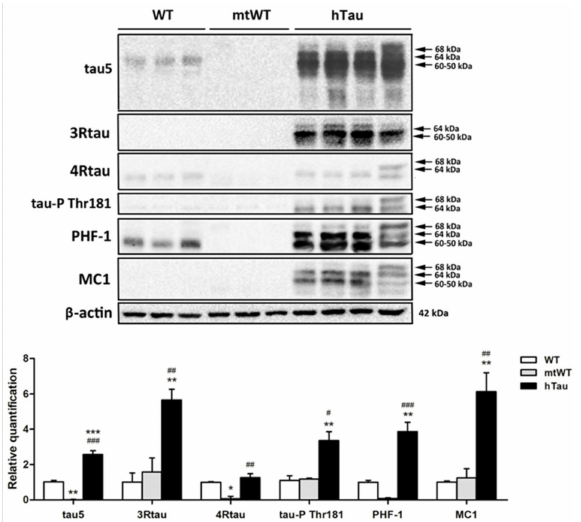
Figure 2. Gel electrophoresis and Western blotting of total brain homogenates from WT, mtWT, and hTau transgenic mice at the age of 9 months processed with Tau 5, 4Rtau, 3Rtau, phosphorylated tau at Thr181 (tau-Pthr181), PHF1, and MC1 antibodies, and processed in parallel. β -actin was used as a control of protein loading. Since the profile of β -actin was similar in the different Western blots, only one representative example is included in the figure. WT mice show the presence of total tau (tau 5), mainly composed of 4Rtau. A PHF1-immunoreactive band is also observed in WT mice; the presence of this band correlates with PHF1 immunoreactivity in the neuropil in these mice. Western blots using tau-P, Thr181, and MC1 antibodies are negative. hTau transgenic mice express a large amount total tau manifested in sbands of 68 kDa, 64 kDa, and 60–50 kDa accompanied by an upper band and several lower bands of smears and truncated tau. It can be seen that 3Rtau is more abundant than 4Rtau; bands of 64 kDa and 60–50 kDa are detected with the 3Rtau antibody, and bands of 68 kDa and 64 kDa with the 4R antibody. PHF1 and MC1 antibodies recognize several bands of about 68 kDa, 64 kDa, and 60–50 kDa. mtWT mice lack tau of any species. The molecular weights labeling tau bands are approximate. Since the samples were run in parallel the molecular weights in the right are also valid for the lanes of WT and mtWT homogenates. The graph shows the relative quantification with Western blotting of tau protein levels in total brain homogenate of WT, mtWT, and hTau mice aged 9 months. One-way analysis of variance (ANOVA) followed by Tukey test. Data are expressed as the mean values ± SEM. The significance level was set at * p < 0.05 ** p < 0.01, *** p < 0.001 vs. WT and # p < 0.05, ## p < 0.01, ### p < 0.001 vs.